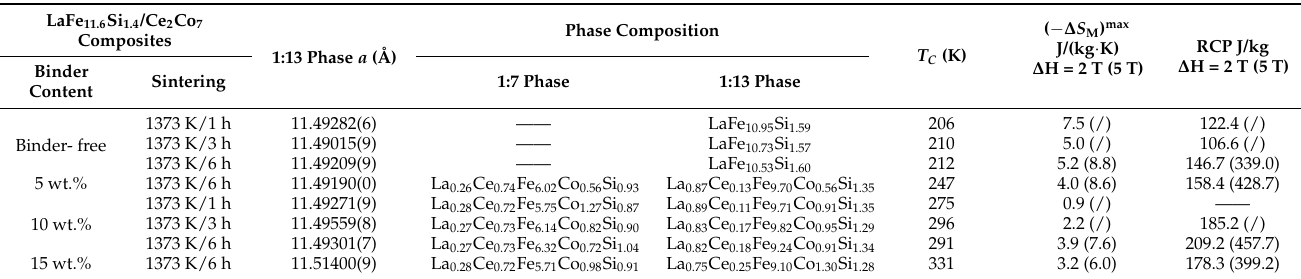
Table 2. Lattice constant ( a ), phase composition, Curie temperature ( T C ), maximum magnetic entropy change (( − ∆ S M ) max ), and relative cooling power (RCP) of LaFe 11.6 Si 1.4 / x wt.%Ce 2 Co 7 ( x = 0, 5, 10 and 15) composites sintered at 1373 K for 1~6